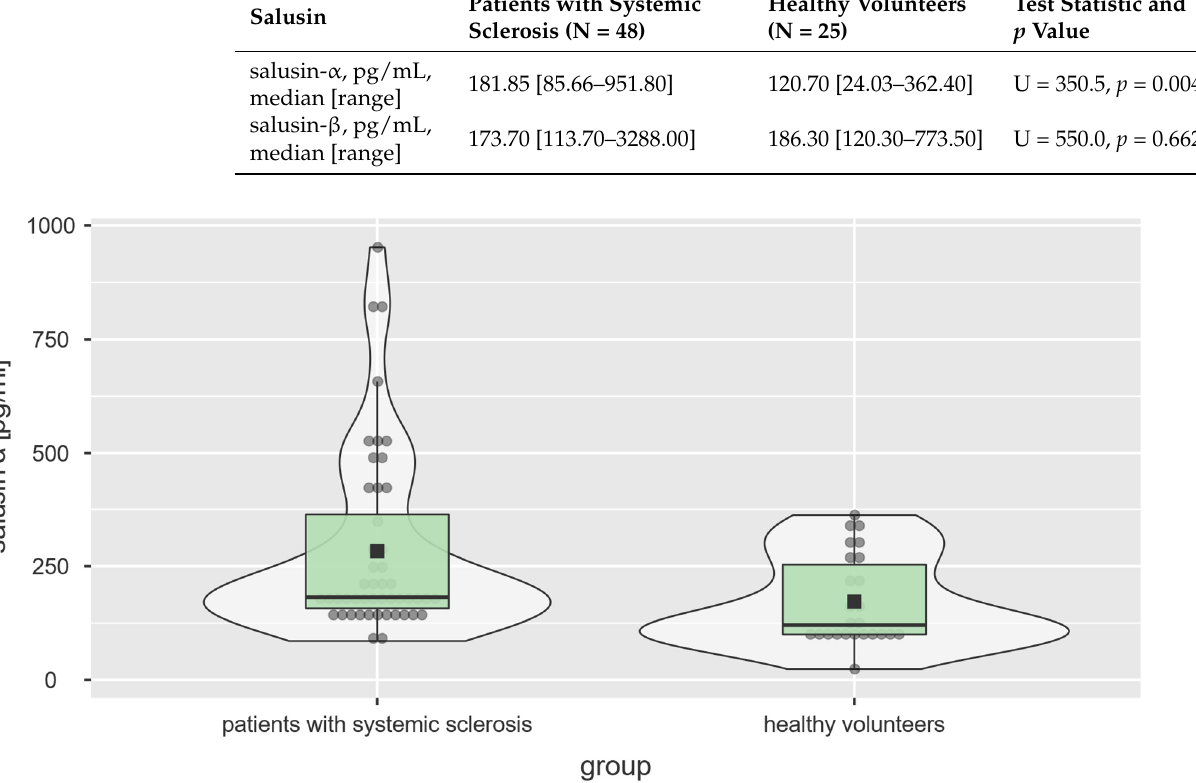
Figure 1. Salusin- α concentrations [pg/mL] in the experimental and control groups (U = 350.5; p = 0.004).